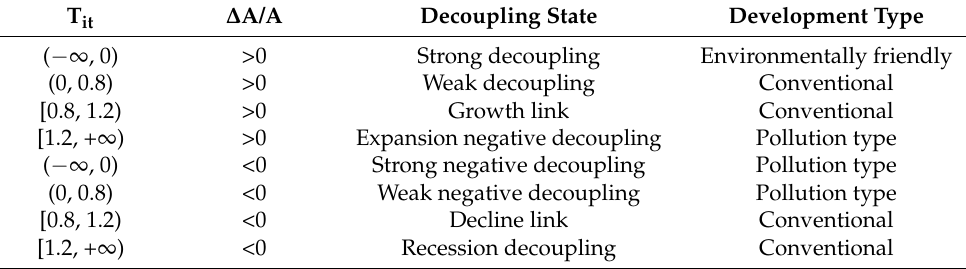
Table 3. Decoupling indicator grade and elasticity value.